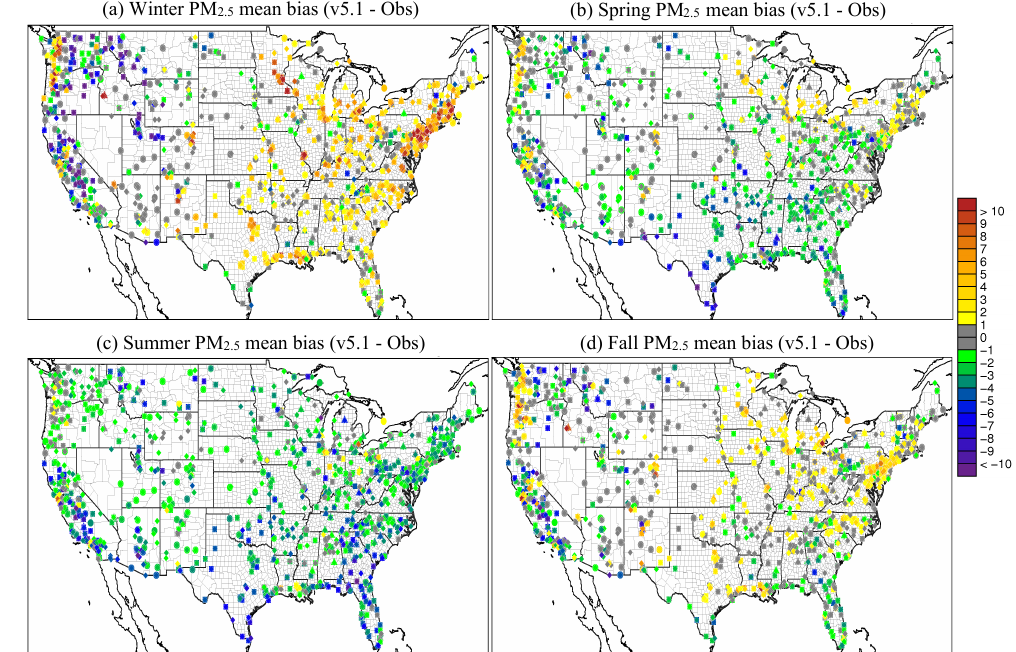
Figure 7: Seasonal average PM 2.5 mean bias (µgm -3 ) at IMPROVE (circles), CSN (triangles), AQS Hourly (squares) and AQS Daily (diamonds) sites for a) winter (DJF) b) spring (MAM) c) summer (JJA) and d) fall (SON) for the CMAQ v5.1_Base simulation.